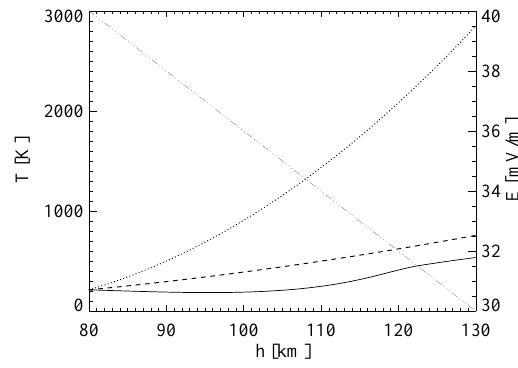
Fig. 1. Temperature according to the Mikhailov-model Eq. (12) (dashed line – α = 0 . 1, dotted line – α = 0 . 3), experimental MSIS- E-90 Atmosphere Model temperature data (VITMO) (full line), and present electric field model E oz = E o ( 1 + az) (dash-dot-dot-dot line) in dependence on the